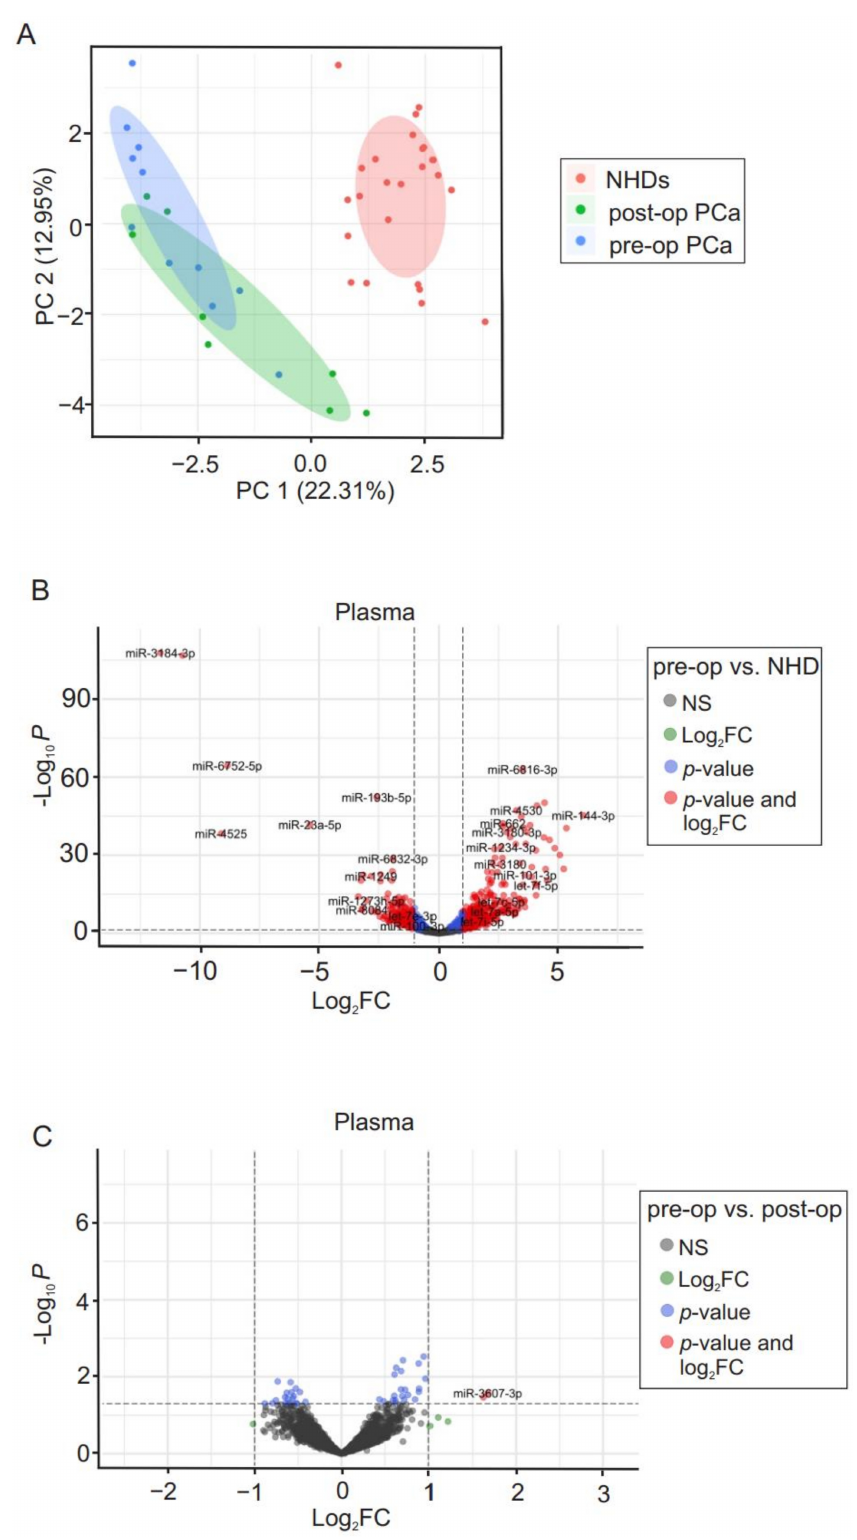
Figure 2. Specific cfmiRs detected in plasma samples from PCa patients. ( A ) The cfmiRs were detected in plasma samples of PCa patients. The scatter plot of PCA axis 1 (PC1) and axis 2 (PC2) shows the pattern of cfmiR detected in plasma samples of NHDs, post-, and pre-operative PCa patients. Individual data points are colored accordingly, NHD (pink), post- (green) and pre-operative (blue) PCa patients. ( B , C ) Volcano plots of DE microRNAs in plasma samples of pre-operative PCa patients vs. NHDs ( B ) and pre- vs. post-operative PCa patients ( C ) are shown, discriminated